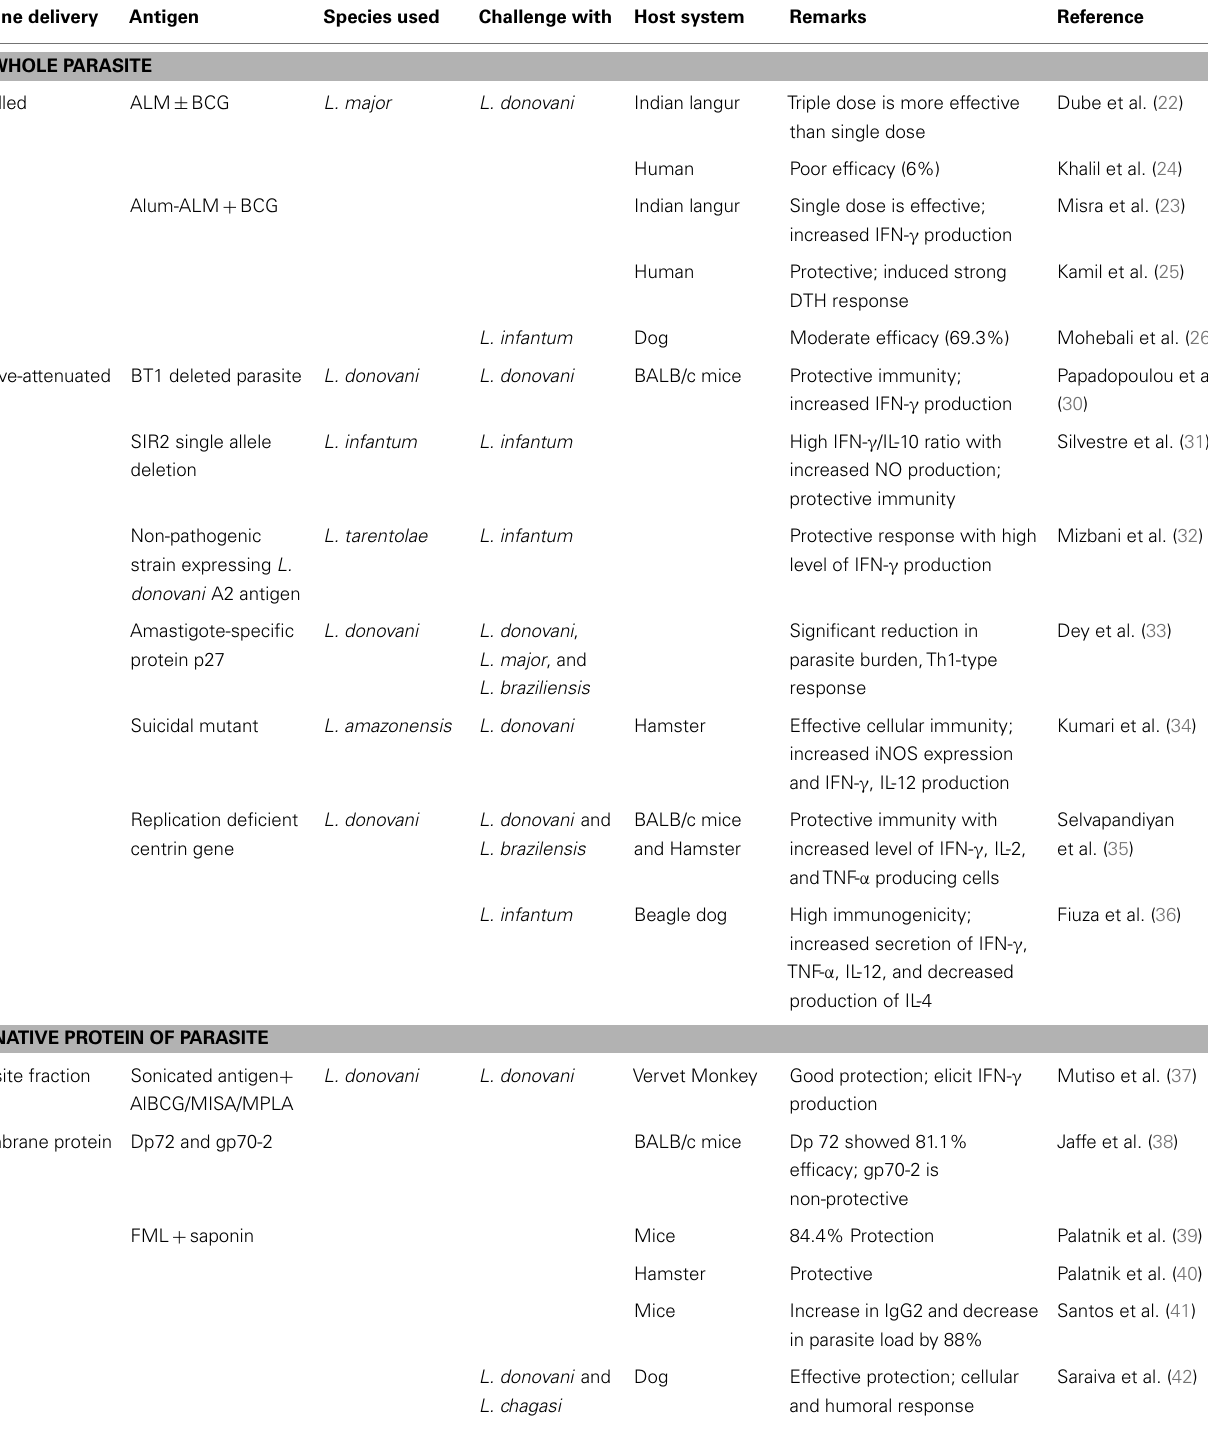
Table 1 | Summary of vaccines evaluated against visceral leishmaniasis . Vaccine